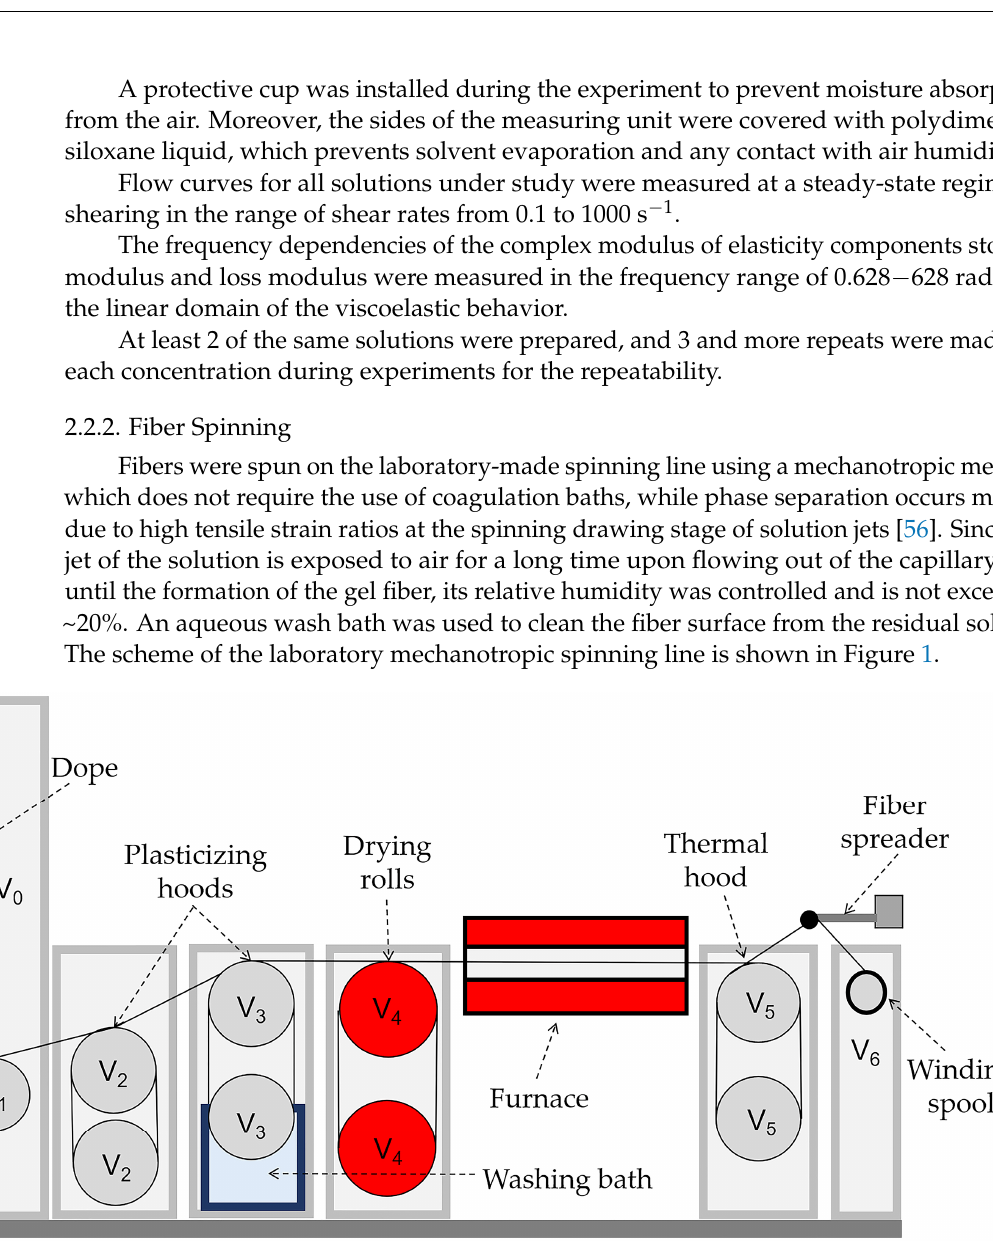
Figure 1. Scheme of the mechanotropic spinning line. V 0 is the speed of the outflow from the die, and V 1 – V 6 are the speeds of the rollers’ rotation.